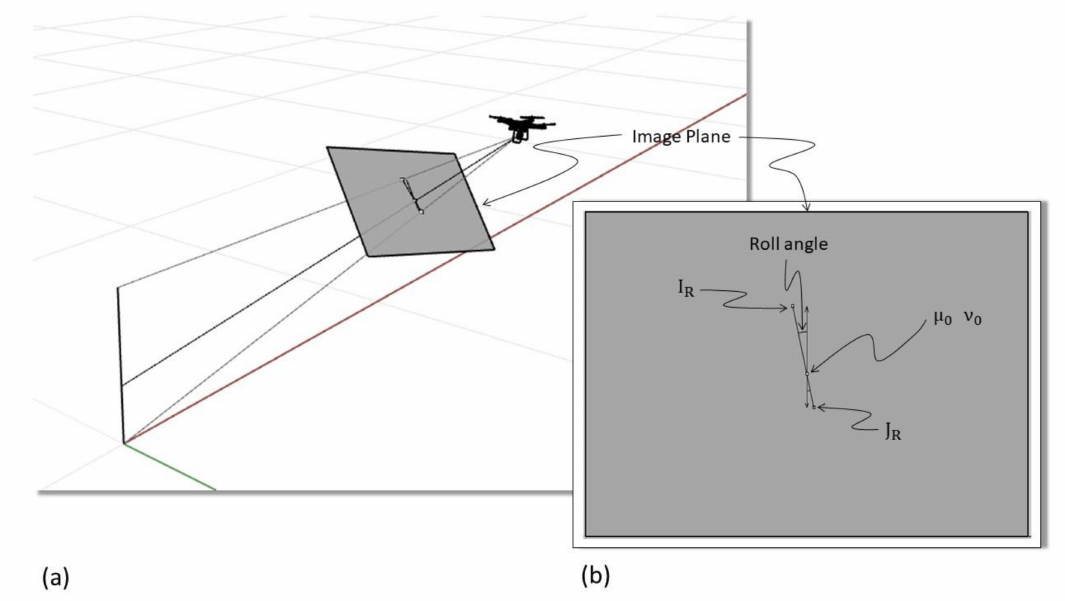
Figure 5. Graphical representation of a lightweight UAV pointing to a vertical pole ( a ) with roll angle di ff erent than zero. Orthogonal view of the image plane ( b ) with the representation of the pole and indication of the roll angle (source: personal collection). Please note that ( a ) is a perspective view, please refer to ( b ) to visualize the image plane without